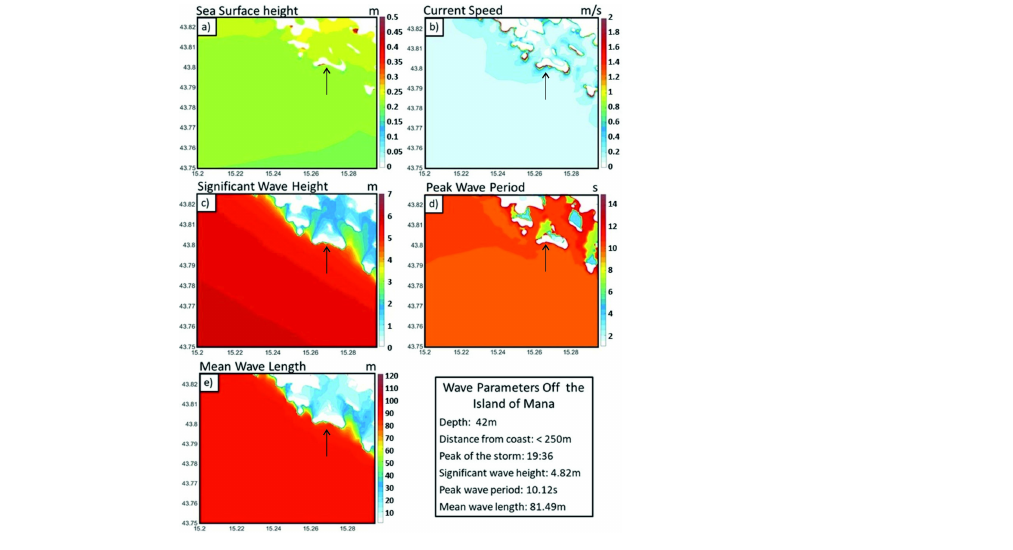
Figure 11. Spatial variability of (1) ADCIRC maximum sea-surface height (a) and maximum current speed ( b ) and (2) unSWAN maximum significant wave height ( c ), maximum peak period ( d ), and maximum mean wave length ( e ) obtained in the vicinity of Mana Island during the peak of the 29 October 2018 Vaia storm. Black arrows point to the island of Mana. Coordinates are in